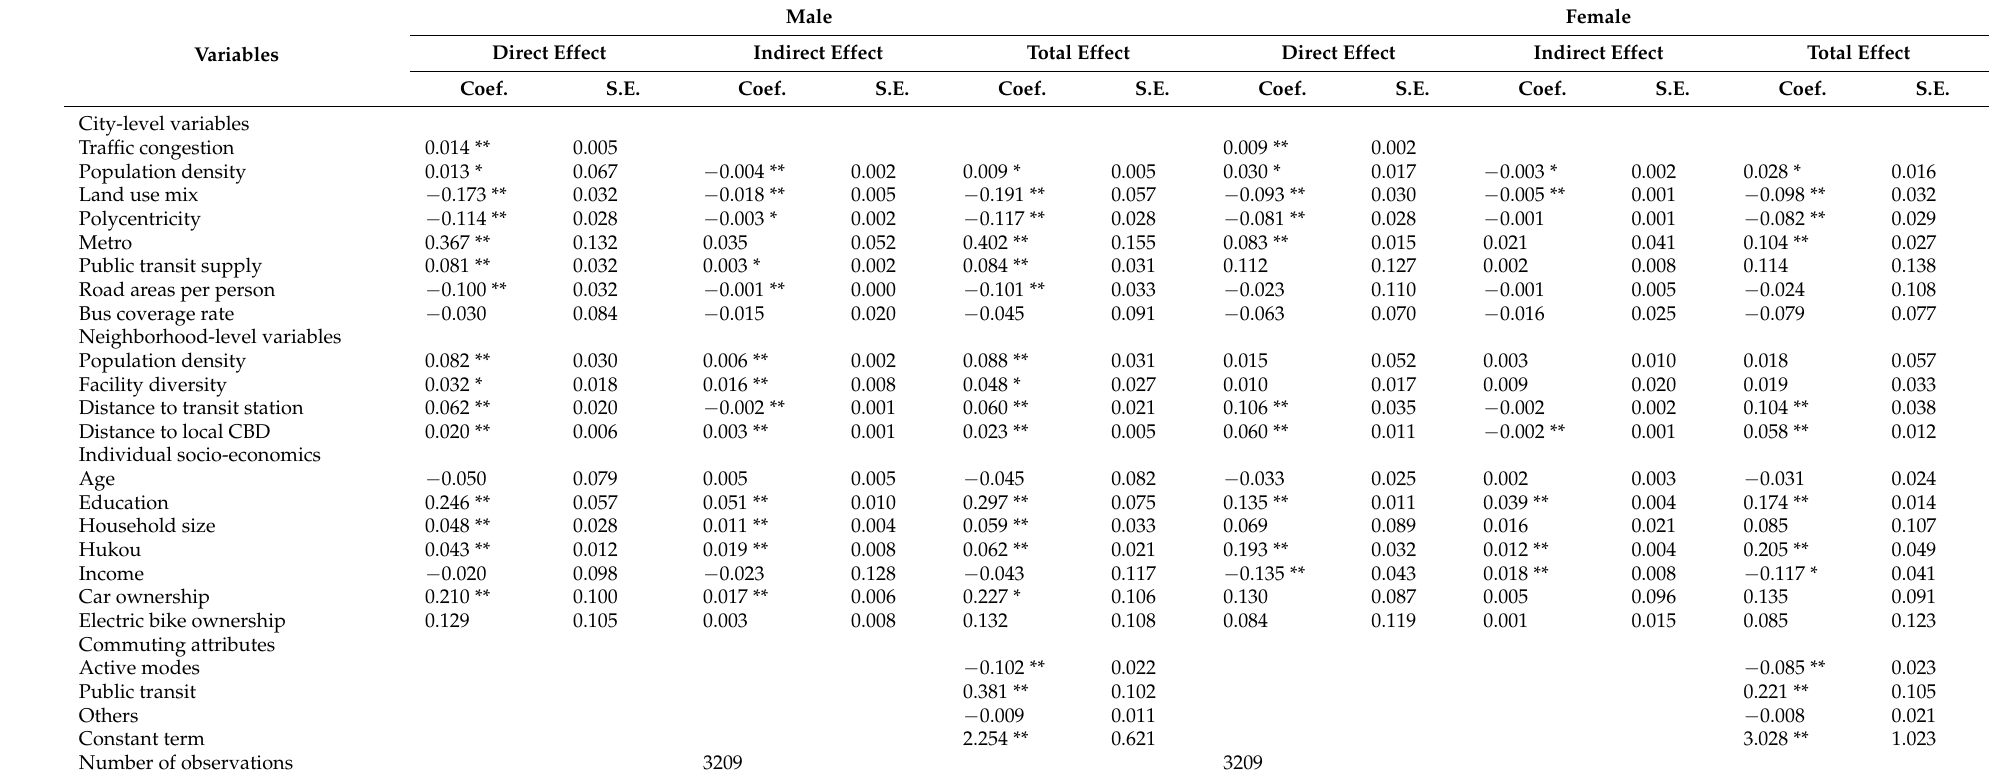
Table 6. Gender differences in the impact of multilevel BE on commuting